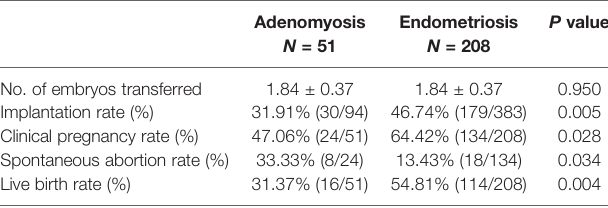
TABLE 3 | Pregnancy outcome for patients undergoing IVF/ICSI with and without uterine